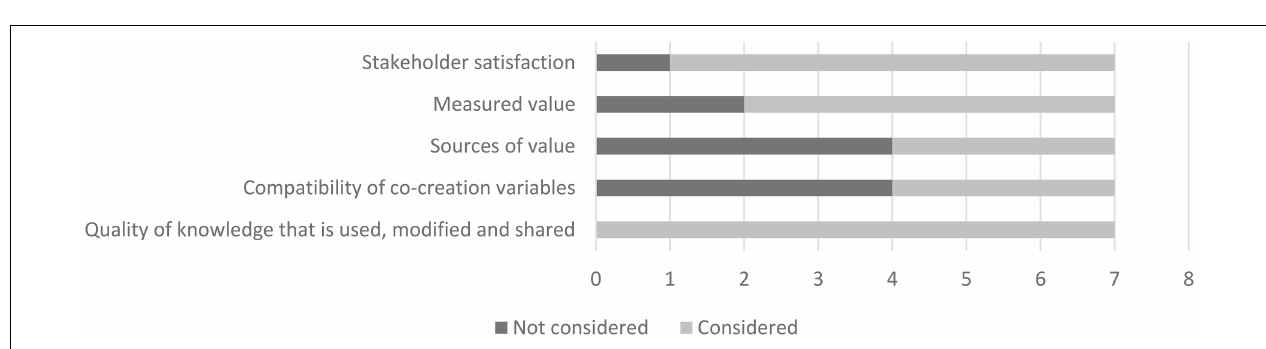
FIGURE 7 | Consideration of concepts that address desired value